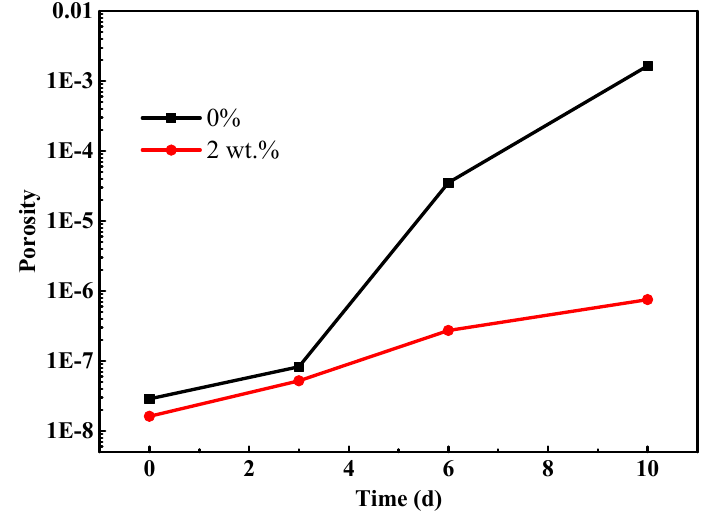
Figure 8. The change trend of coating porosity with the salt spray time.